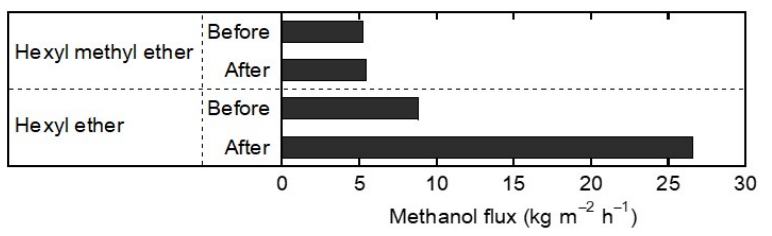
Figure 8. Effects of vapor exposure tests with hexyl methyl ether and hexyl ether on methanol flux of the FAU-type zeolite membranes (5 SiO 2 :1 Al 2 O 3 :17 Na 2 O:1000 H 2 O, 16 h synthesis).